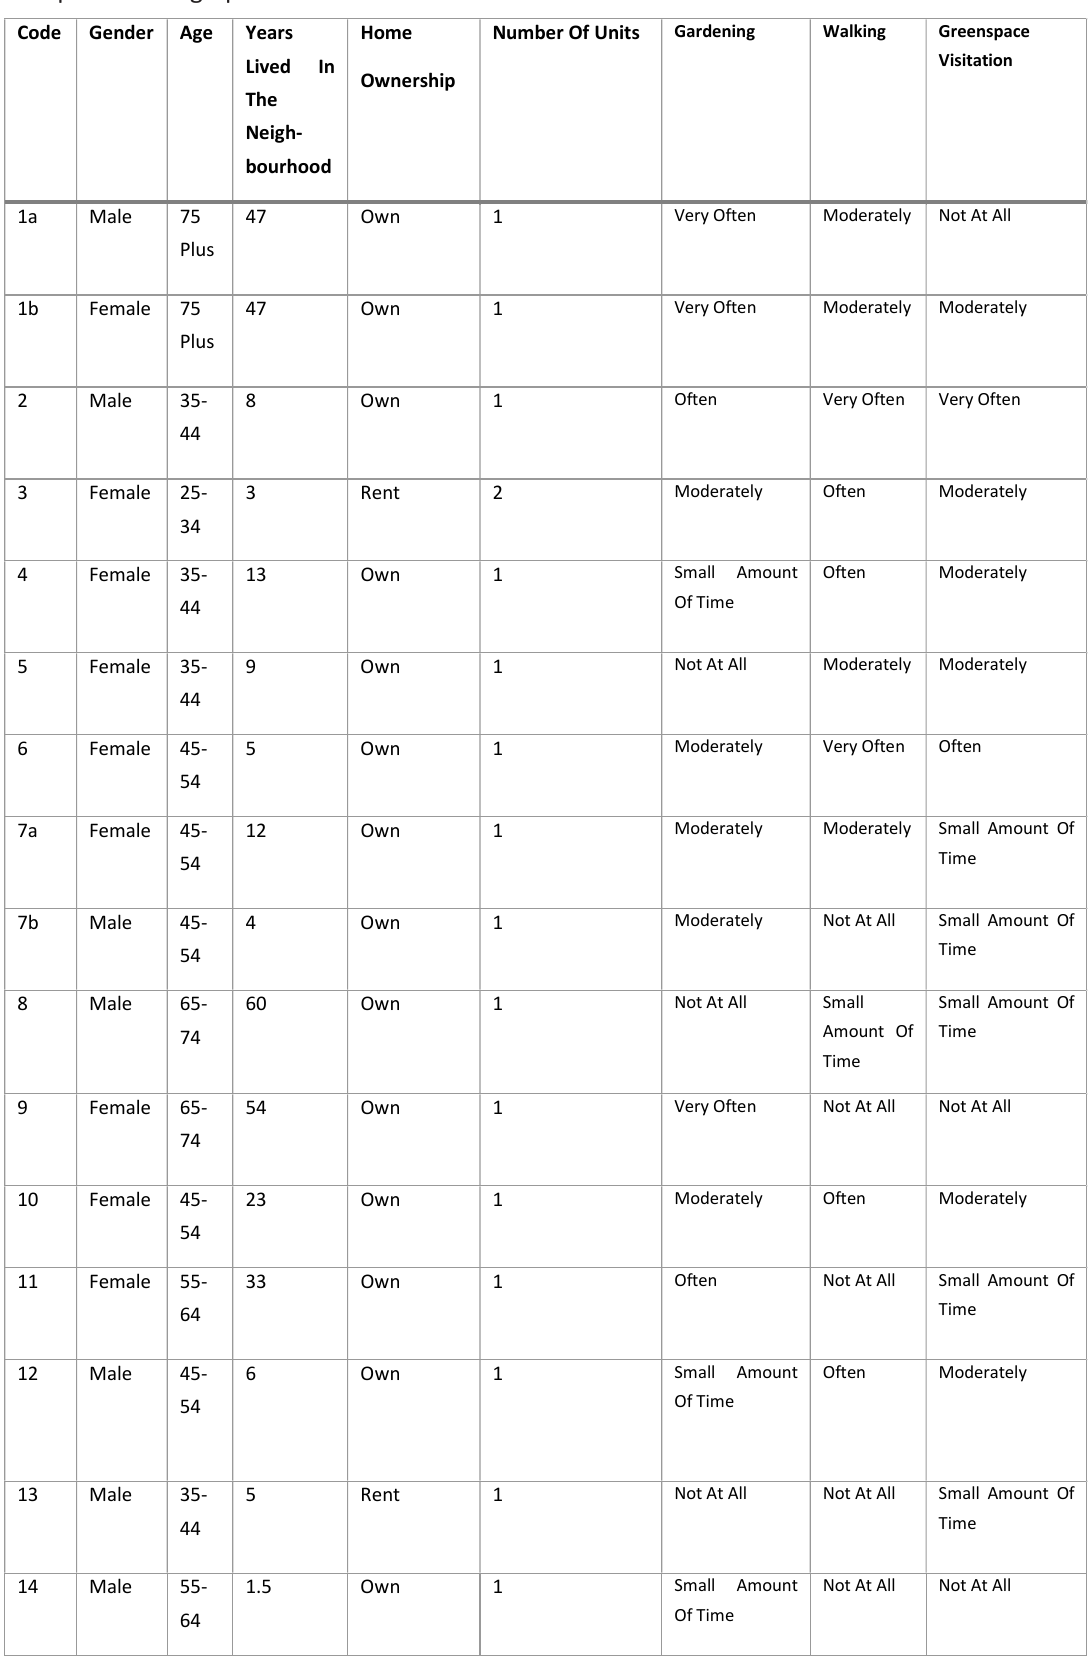
Table 1: Participants demographic